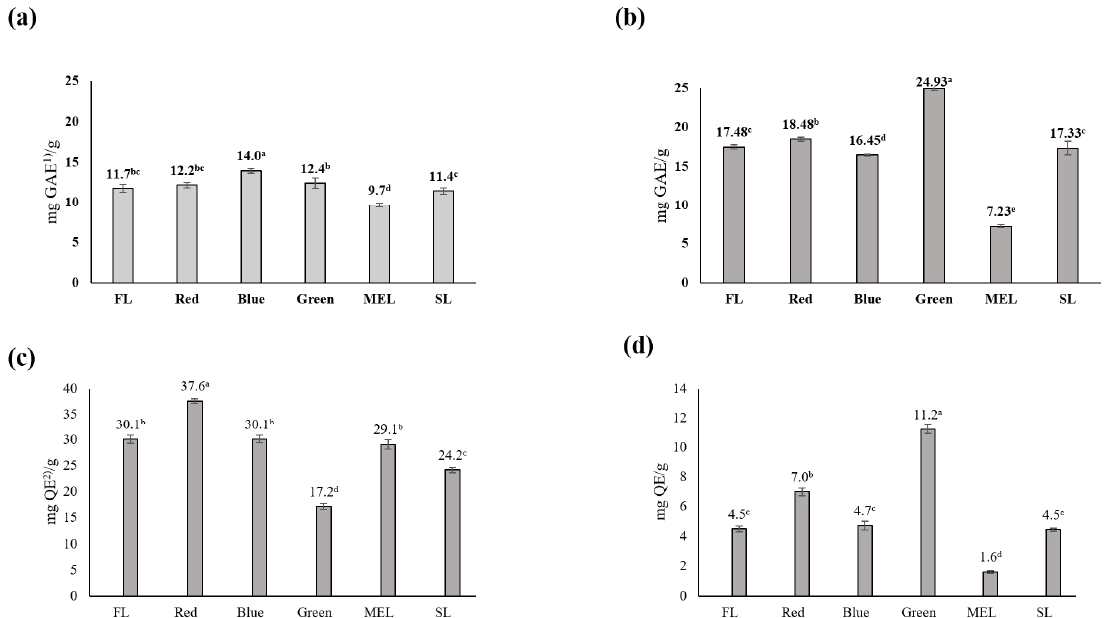
Figure 3. Total phenolic ( a , b ) and flavonoid ( c , d ) contents of aerial and underground parts from extracts of A. macrocephala under different light sources. (1) GAE; gallic acid equivalents. (2) QE; quercetin equivalents. Values represent mean of data obtained from three independent experiments ( p < 0.05). Significance was indicated with different letters according to statistical analysis.